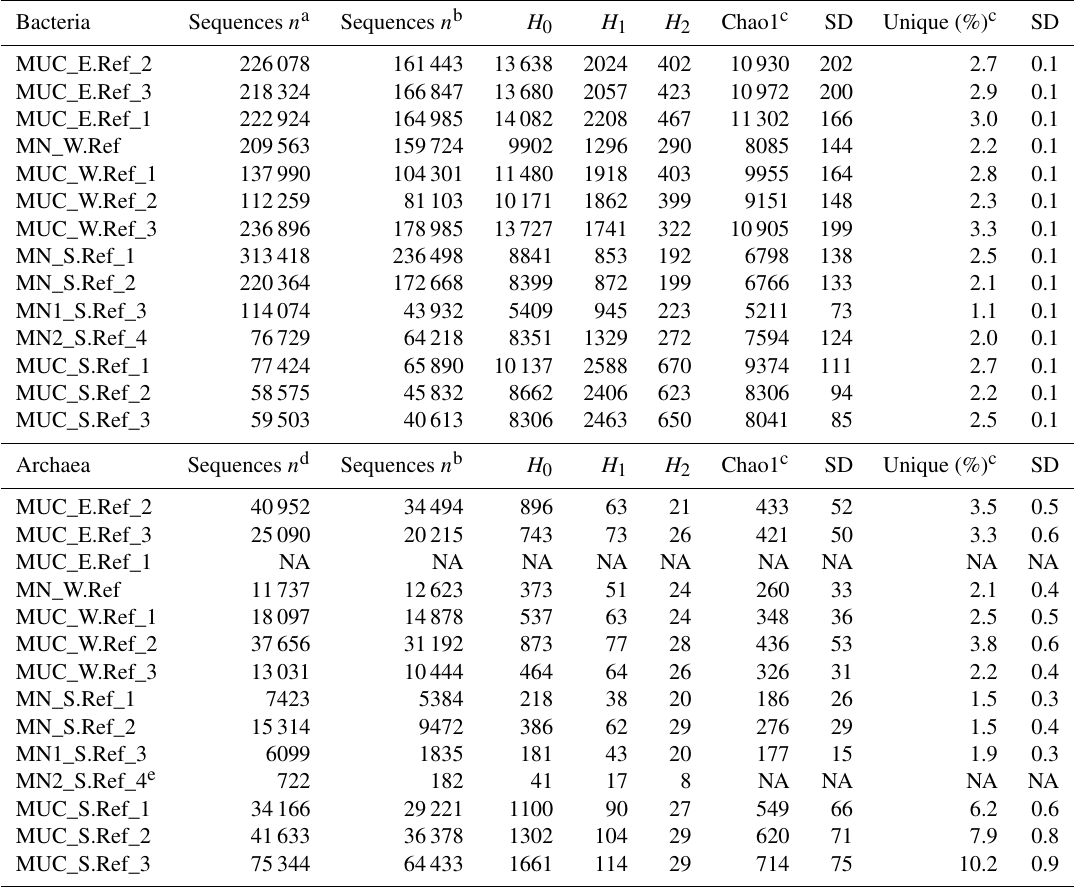
Table 2. Bacterial and archaeal diversity indices and unique OTUs for all nodules and sediment samples. Indices and unique OTUs were calculated without